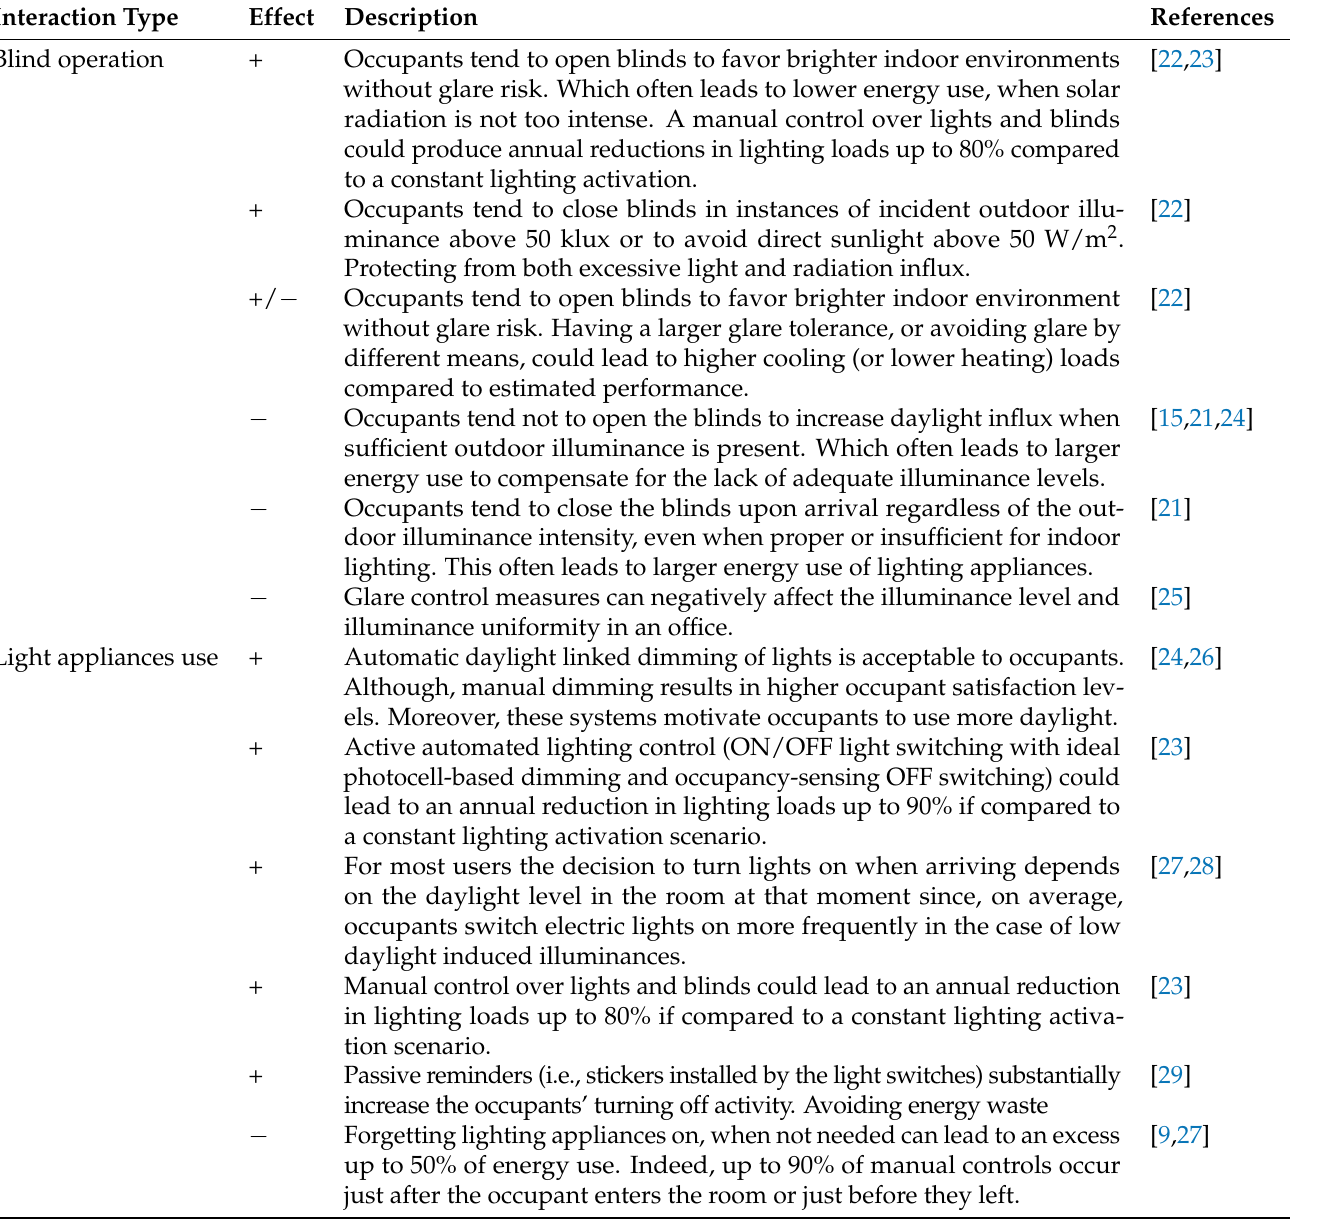
Table 1. Summary of the effects (positive [+] or negative [ − ]) of occupant–building interaction on building energy